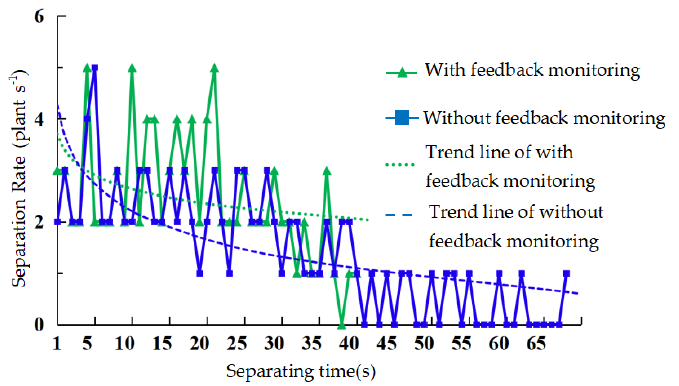
Figure 10. Separation rates of seedlings in the separation operation.